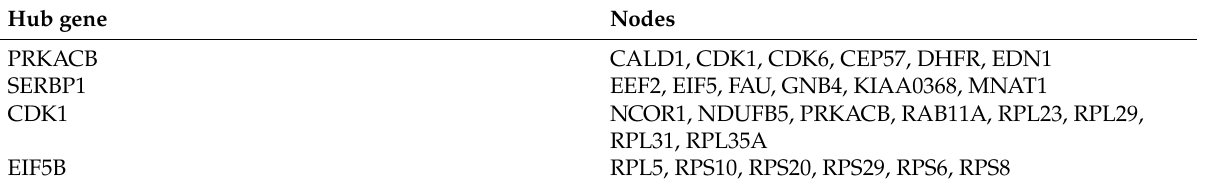
Table 3: List of Hub genes with their respective nodes across AR, MAPK and mTOR pathway. Hub gene Nodes